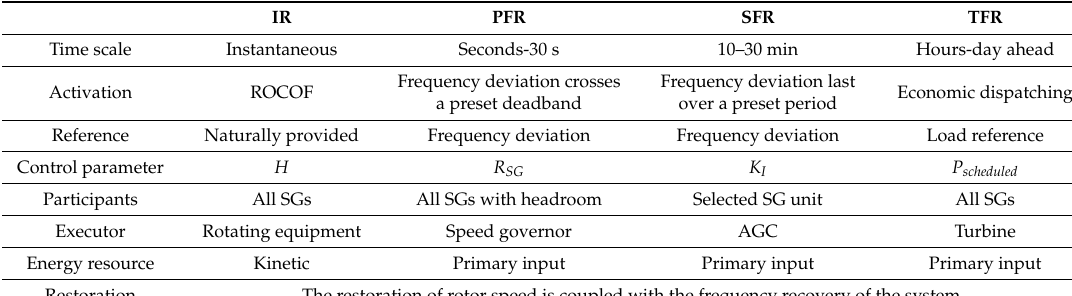
Table 1. Conventional multiple temporal frequency